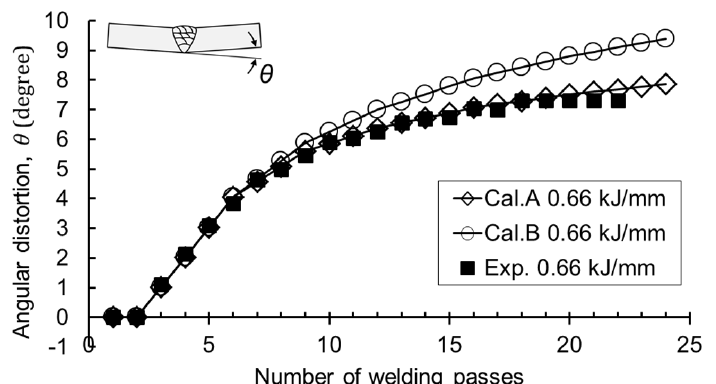
Figure 13. Comparison of the calculation; Cal.A: considering the previous bead, Cal.B: not considering the previous